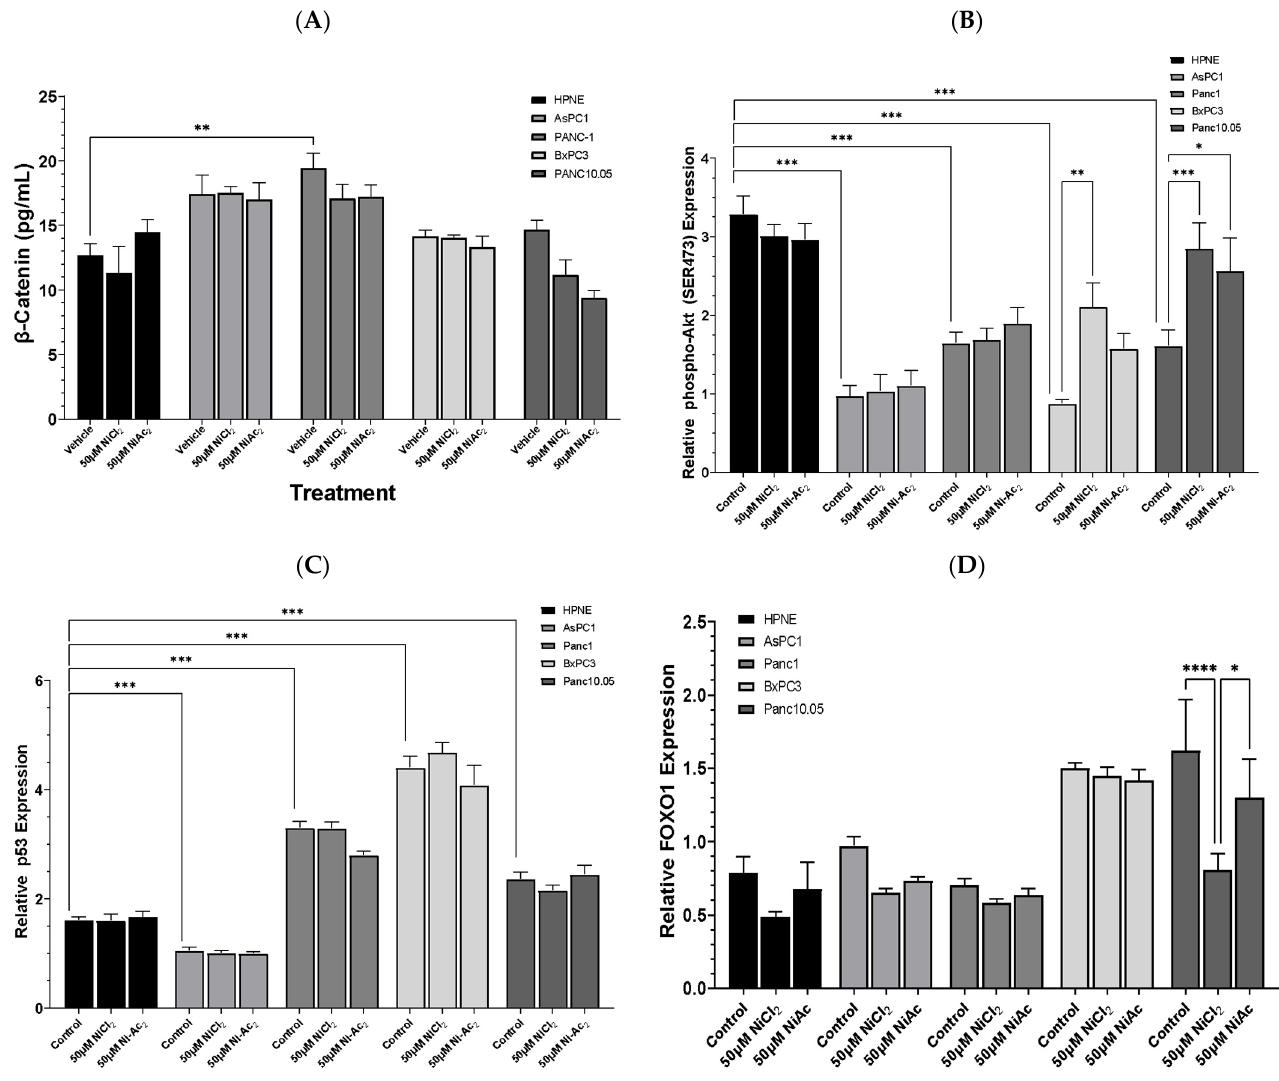
Figure 5. Quantification and expression of key cell function proteins after 48 h exposure to 50 µ M NiCl 2 or Ni-acetate in PDAC cell lines. These assays quantified the amount of β -catenin ( A ), phospho-AKT ( B ), p53 ( C ), and FOXO-1 ( D ). The predominant difference was in the basal levels of each protein and the differences between the cell lines. The expressions of phospho-AKT ( B ) and p53 ( C ) typify this response. Treatment with either NiCl 2 or Ni-acetate had little effect after 48 h, except for phospho-AKT ( B ) and FOXO-1 ( D ), in which NiCl 2 and Ni-acetate increased phospho-AKT expression and decreased FOXO-1 expression in Panc-10.05 cells. In BxPC-3 cells, exposure to NiCl 2 increased phospho-AKT expression 146% compared to vehicle control. Data are expressed as the mean ± SD of 4 assays performed in duplicate (* p < 0.05; ** p < 0.01; *** p < 0.001; **** p < 0.0001).